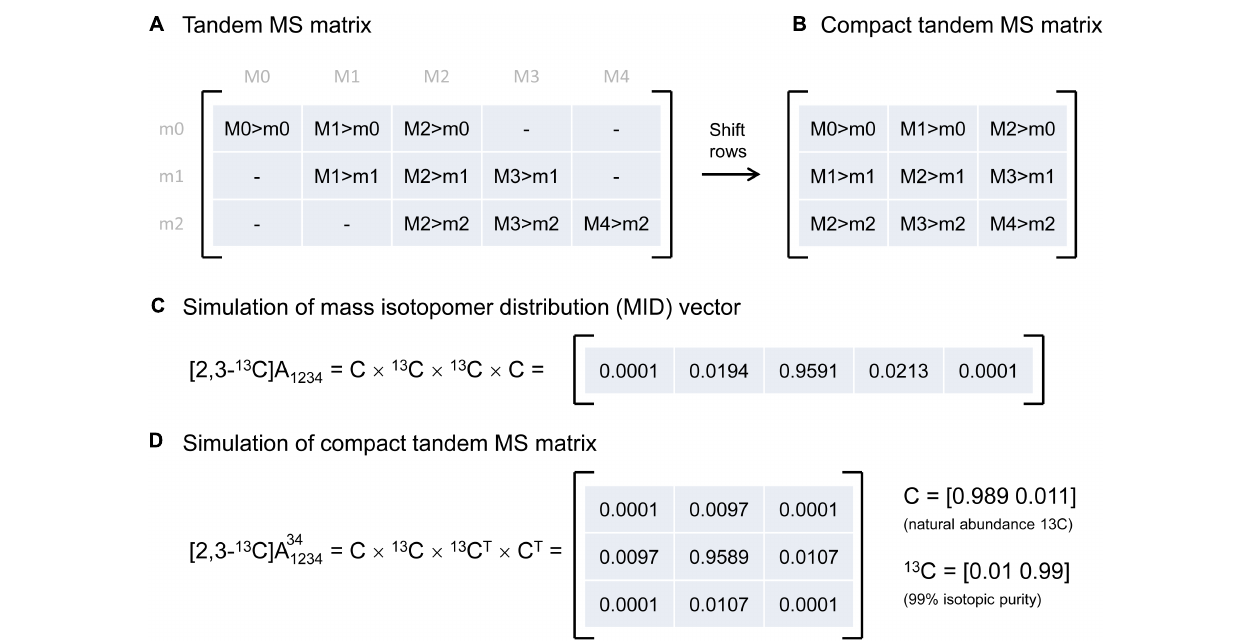
FIGURE 1 | (A) Representation of tandem mass spectrometry data using a tandem MS matrix, and (B) a compact tandem MS matrix. (C) A mass isotopomer distribution vector can be simulated efficiently by a series of convolutions (denoted by “ × ”). (D) A compact tandem MS matrix can be simulated analogously by a series of 2D-convolutions (denoted by “ × ”). For illustration purposes, the MID vector and the compact tandem MS matrix were simulated for a four-carbon metabolite A that is 13 C-labeled at carbon positions 2 and